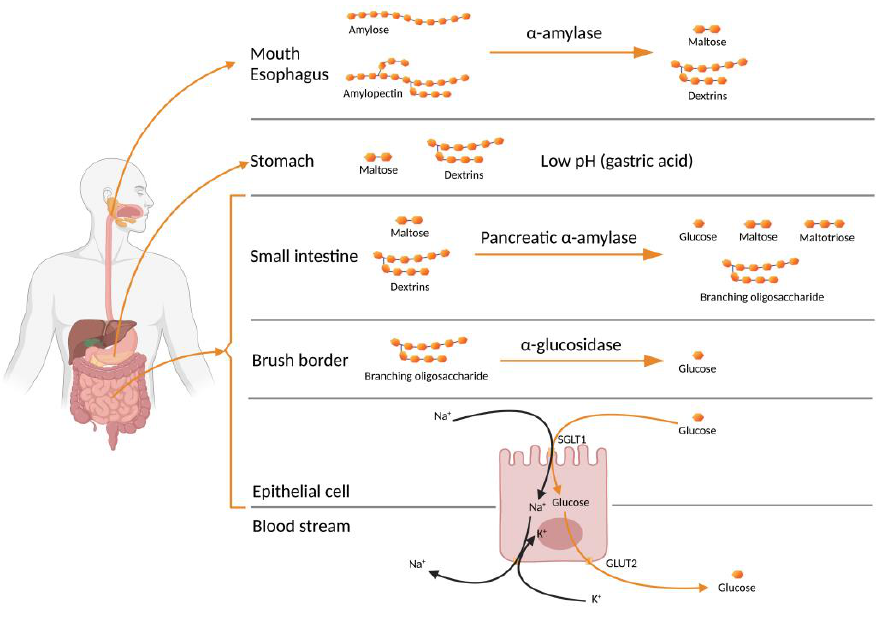
Figure 2. Starch digestion (Created with BioRender.com).